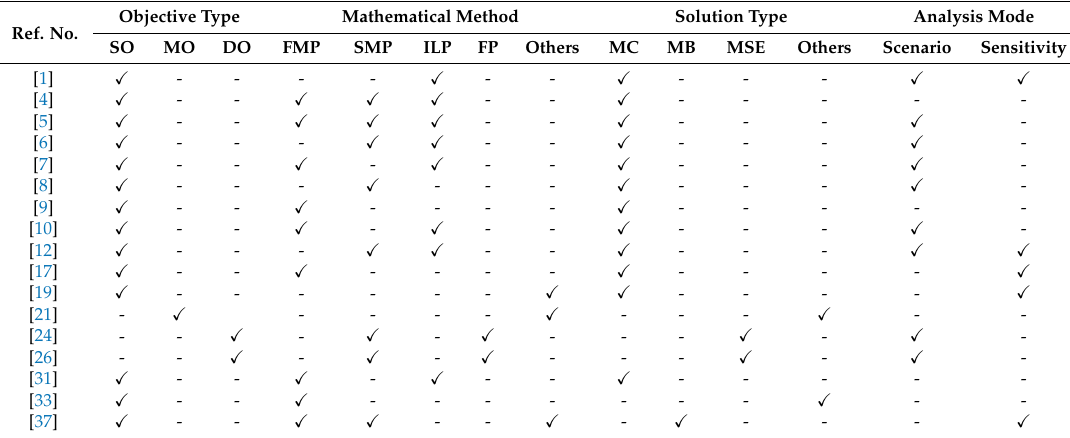
Table 1. Previous studies related to the